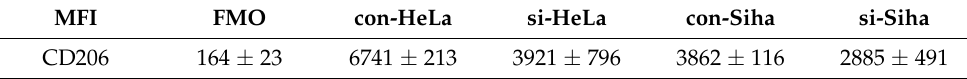
Figure 3. CCL22 could polarize TAMs towards M2a macrophages in cervical cancer via an autocrine pathway. Total RNA from si-CCL22-TAMs and con-TAMs was analyzed by real-time PCR in triplicate for CCL22 mRNA expression ( a ). Flowcytometric analysis of MFI (mean fluorescence intensity) of CD206 on the surface of CCL22 silenced cells (si-CCL22) TAMs and unsilenced controls (con-TAMs) co-cultured with HeLa and Siha cells ( b , d ). Total RNA from CCL22-vectors treated TAMs and con-TAMs was analyzed by real-time PCR in triplicate for CCL22 mRNA expression ( f ). Flowcytometric analysis of MFI (mean fluorescence intensity) of CD206 on the surface of CCL22-vectors-treated TAMs and con-TAMs co-cultured with HeLa and Siha cells ( g , i ). Red line represents MFI of FMO CD206 group; blue line represents MFI of control CCL22 group; orange line represents si-CCL22 or CCL22-vectors treated group. Bar graphs ( c , e , h , j ) represent the mean and SD of MFI of CD206 in treated macrophages co-cultured with cervical cancer cell line HeLa and Siha, respectively, for at least three independent experiments. * Represents p < 0.05. Table 2. MFI of CD206.